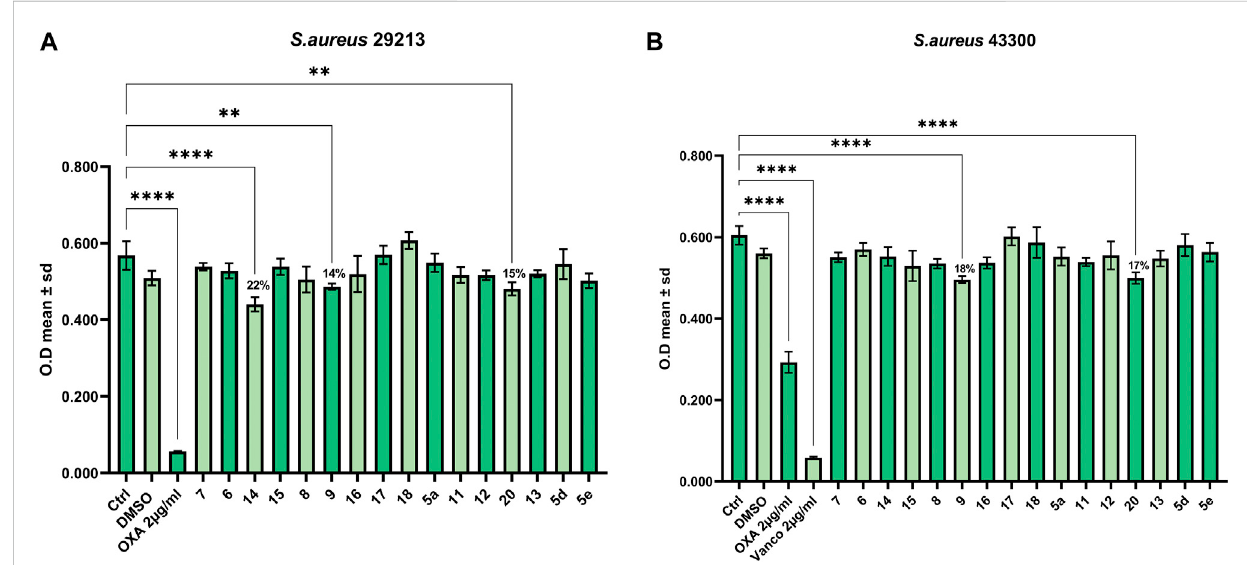
FIGURE 1 Antibacterial effect against Gram-positive (A) S. aureus ATCC 29213 and (B) S. aureus ATCC 43300.